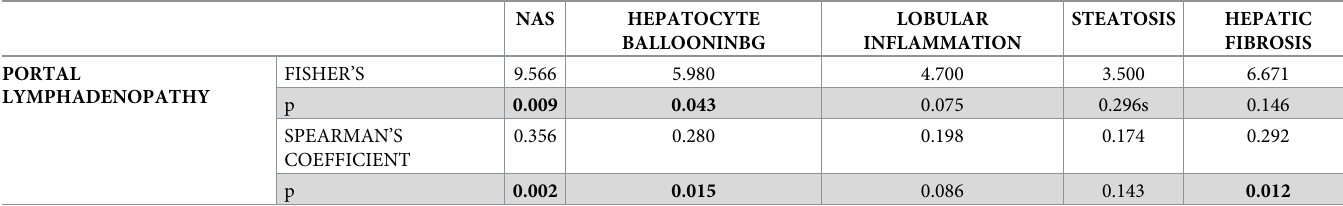
Table 5. Correlation of PL with NAS, NAS components and fibrosis-univariate analysis.